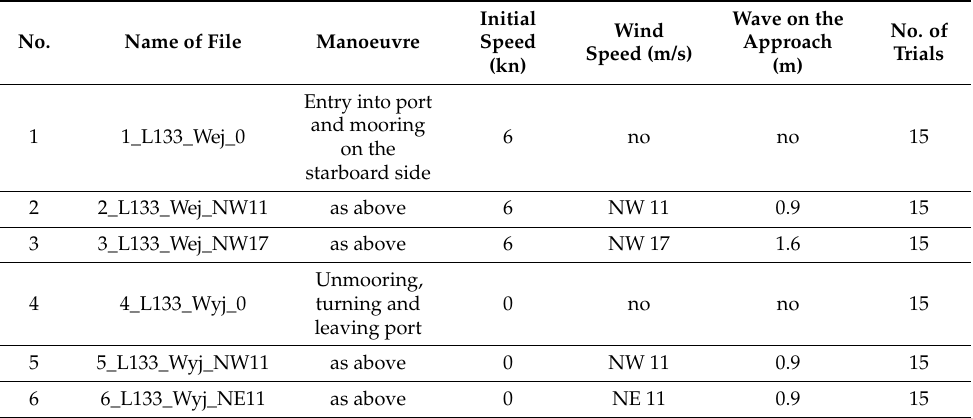
Table 1. The plan of simulation research in Ustka.